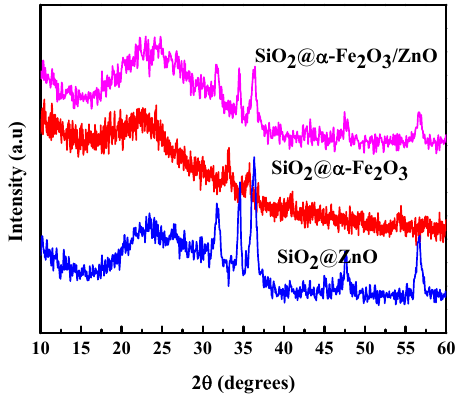
Figure 1. X-ray diffraction (XRD) pattern of SiO 2 @ZnO, SiO 2 @ α -Fe 2 O 3 and SiO 2 @ α -Fe 2 O 3 /ZnO nanocomposites.